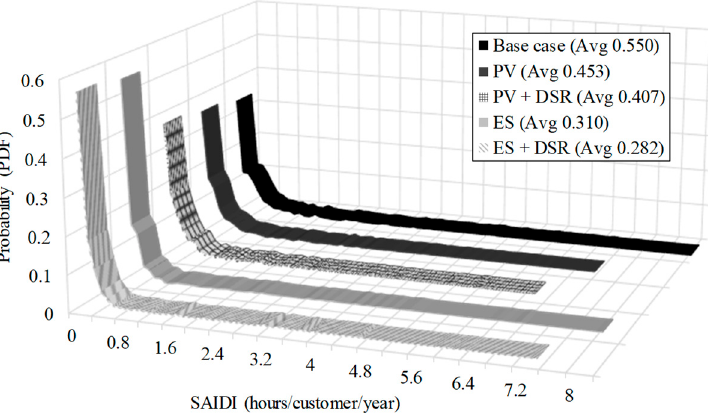
Figure 14. Comparison of the PDFs for the SAIDI index.